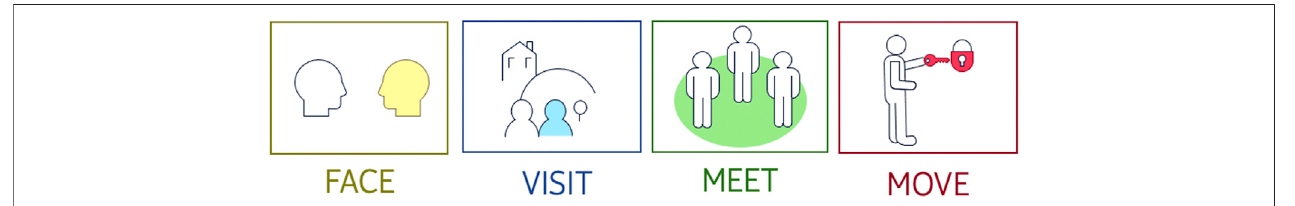
FIGURE 1 | Fundamental elements of immersive communication systems.